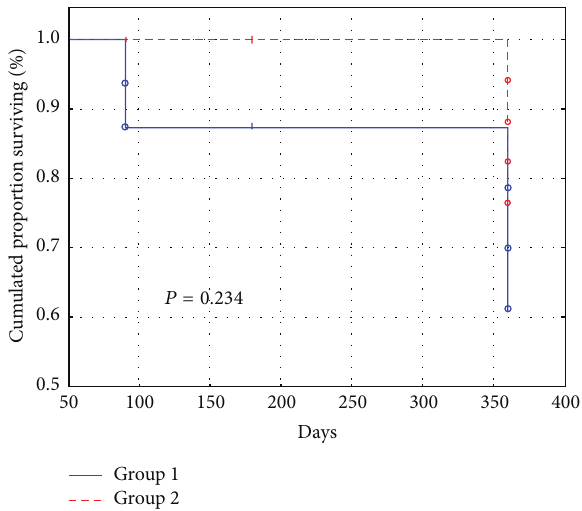
Table 5: Postoperative